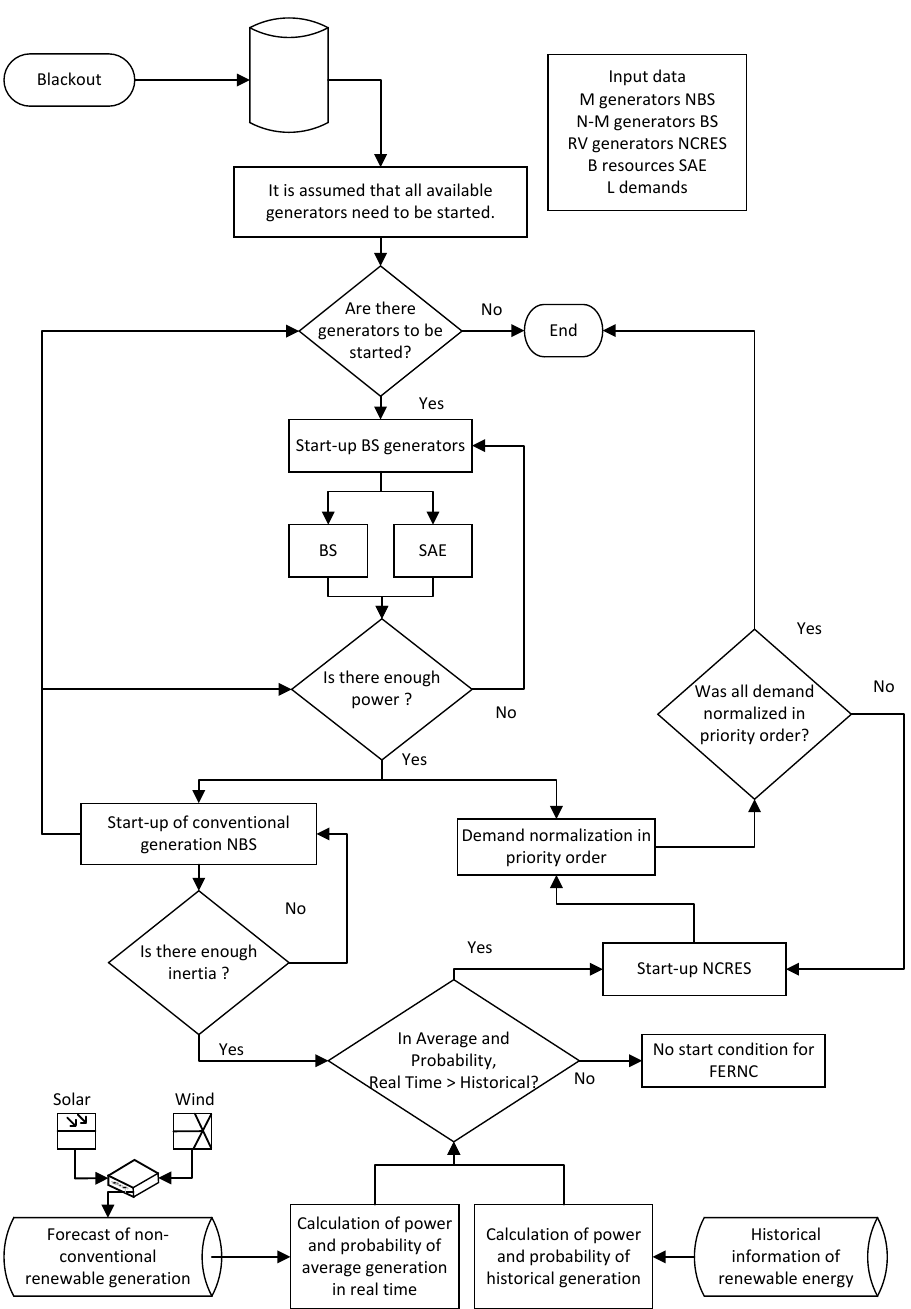
Figure 1. Flow chart of the conventional and non-conventional generation start-up